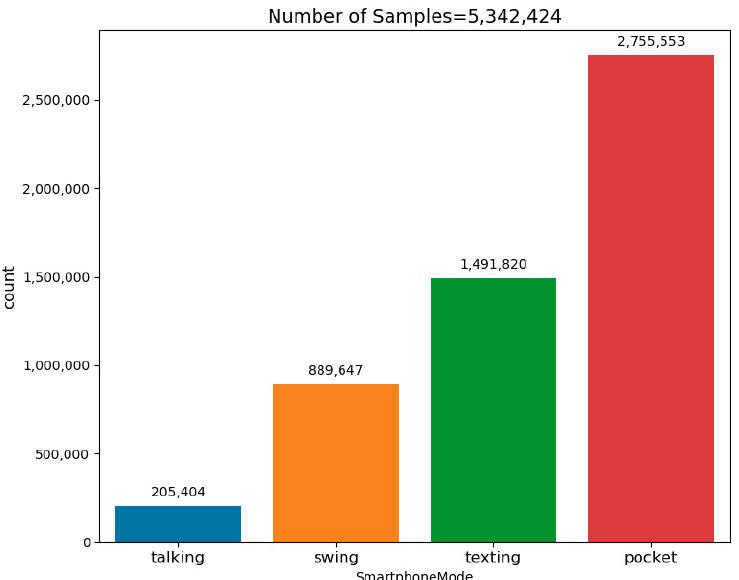
Figure 9. The final dataset’s (comprising of the eight different datasets) sample distribution to each of the possible smartphone locations.